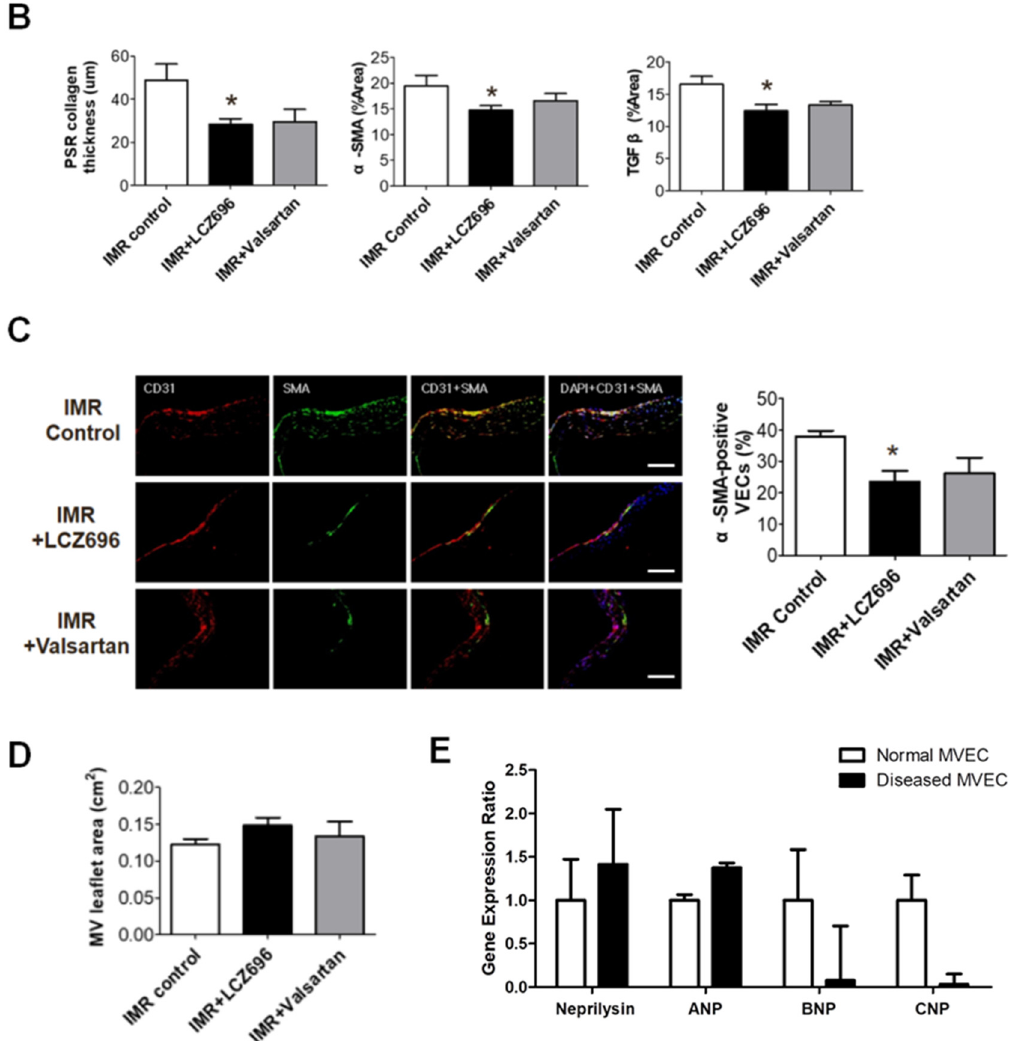
Figure 3. ( A ) Comparison of representative light microscopy image from immune-histochemical staining of the mitral leaflets among the three groups. Scale bar = 50 µm. PSR staining demonstrates marked fibrotic thickening of the mitral leaflets in the IMR control group. This thickening is associated with an increase in excessive endothelial-to-mesenchymal transition represented by α -SMA and TGF- β immunostains. ( B ) Quantification of the PSR collagen thickness ( µ m), the α -SMA- and the TGF- β -positive areas (% of the mitral leaflet). ( C ) Representative immunofluorescence staining images of CD31 and α -SMA in the mitral leaflets from the three groups. Scale bar= 50 µm. Nuclei were stained with DAPI (blue). Merged images are shown and quantitative graph indicates the proportion of α -SMA(+) CD31(+) cells of total CD31(+) endothelial cells. ( D ) Comparison of mitral leaflet area among the three groups of animal experiments. ( E ) Gene expression levels of neprilysin and natriuretic peptides from hMVECs. IMR indicates ischemic mitral regurgitation; PSR, picrosirius red stain; α -SMA, α -smooth muscle actin; TGF- β , transforming growth factor- β ; CD31, cluster of differentiation 31; DAPI, 4 (cid:48) ,6-diamidino-2-phenylindole; VEC, valvular endothelial cell; hMVEC, human mitral valvular endothelial cell; ANP, A-type natriuretic peptide; BNP, B-type natriuretic peptide; CNP, C-type natriuretic peptide. * p < 0.05 for differences from the control